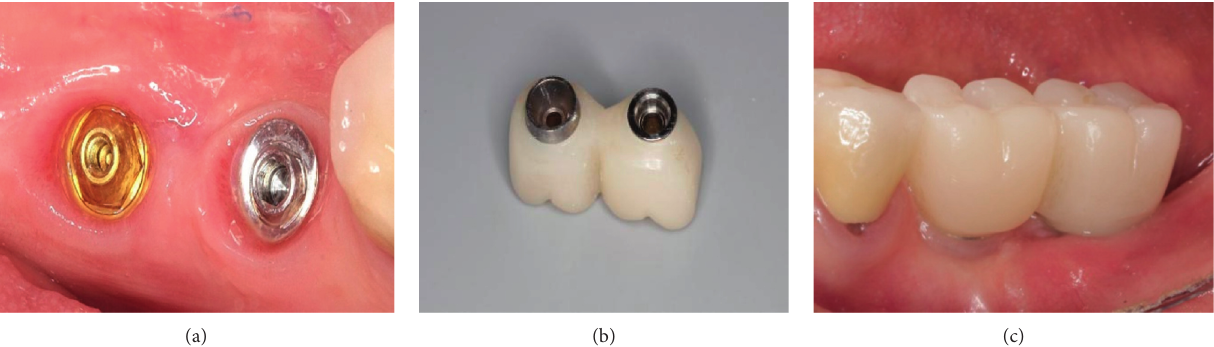
Figure 2: Temporary rehabilitation of a patient from the level of removable platform switching bases at the stage of prosthetics.